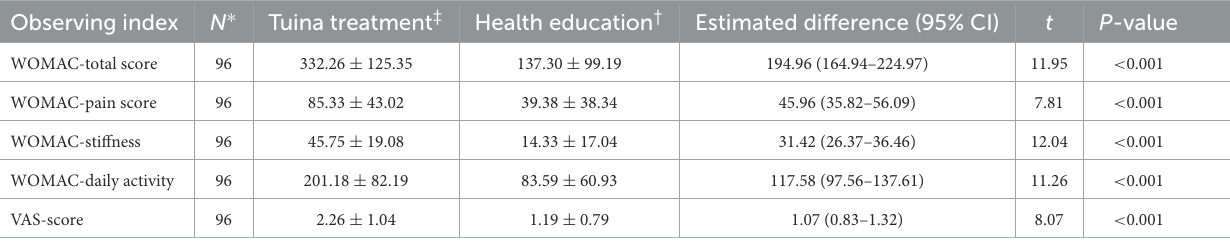
TABLE 5 Comparison of change in different intervention